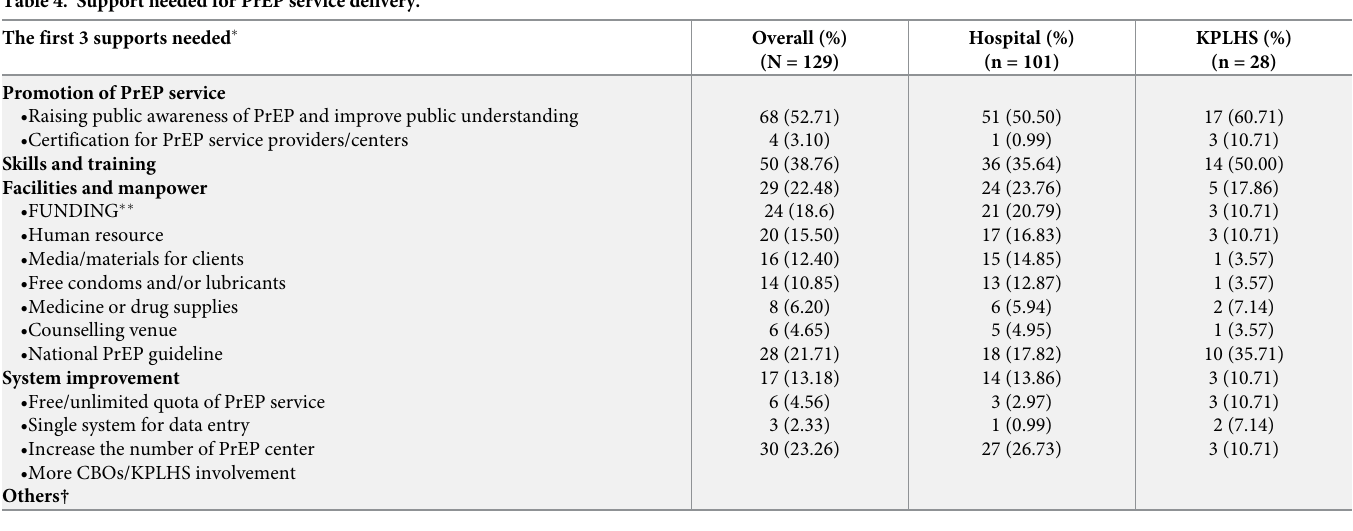
Table 4. Support needed for PrEP service